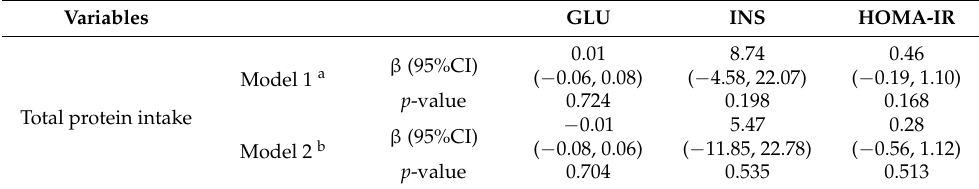
Table 3. The multiple linear regression results of total protein intake and GLU, INS, or HOMA-IR.